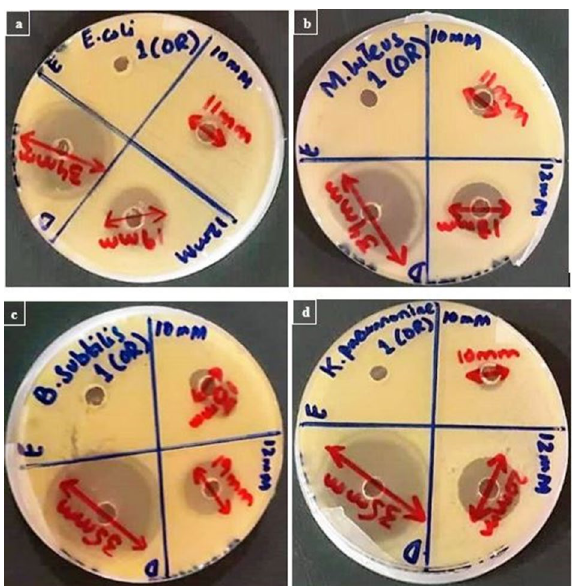
Figure 4. Antimicrobial activity analysis of SeNPs synthesized from Citrus paradisi (Grapefruit) fresh juice extract against bacterial pathogens; ( a ) E. coli , ( b ) M. luteus , ( c ) B. subtilis , ( d ) K. pneumoniae .